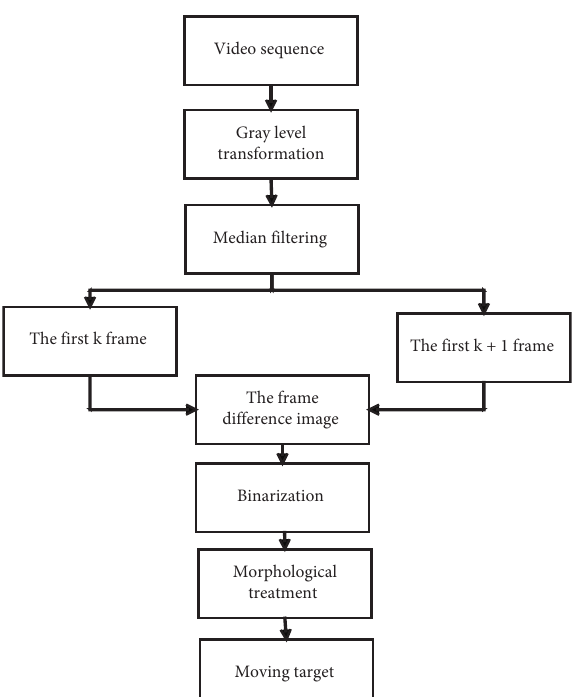
Figure 1: Block diagram of